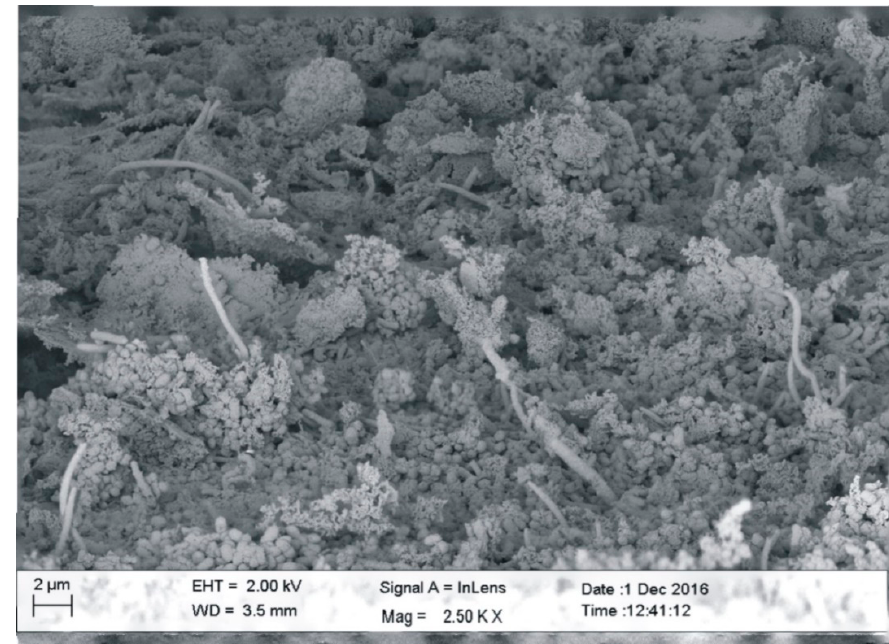
Figure 4. Surface of the five days growth biofilm on the enamel surface. A well-established biofilm can be seen with spirals, cocci, and rods.